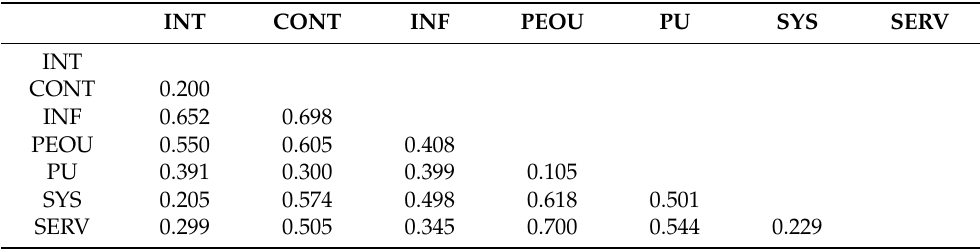
Table 6. Heterotrait–Monotrait Ratio